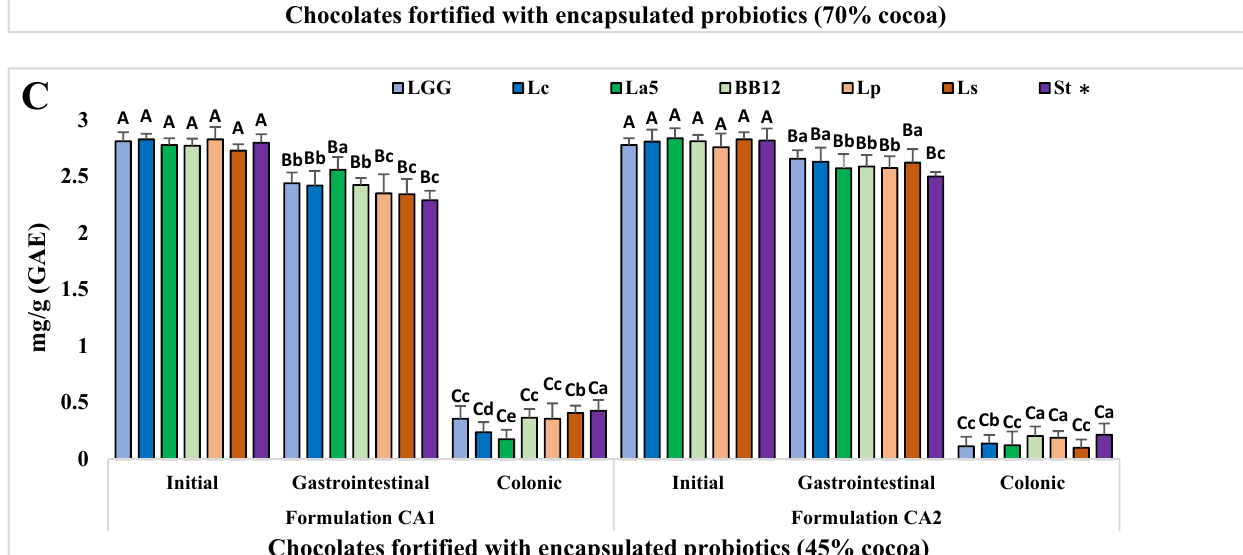
Figure 1. Total polyphenol content in probiotic-chocolate subjected to gastric digestion and colonic fermentation. ( A ) positive control, ( B ) probiotic-chocolate with 70% cocoa mass, and ( C ) probiotic- chocolate with 45% cocoa mass. * BB12: B. animalis spp. lactis , La5: L. acidophilus , Lc: L. casei , LGG: L. rhamnosus , Lp: L. plantarum , Ls: L. sanfranciscensis , St: S. thermophilus , n = 6. Columns with different uppercase superscript letters in different treatments indicate statistically significant ( p < 0.05). Column with different lowercase superscript letters within each treatment indicate statistically significant ( p < 0.05).